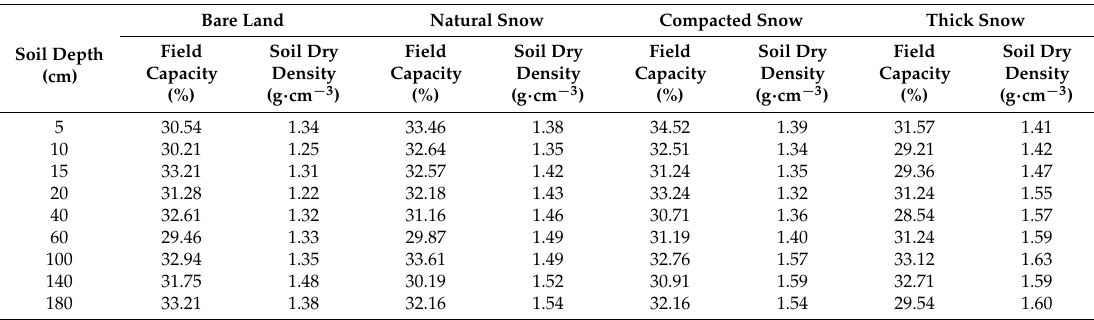
Table 1. Soil physical properties.